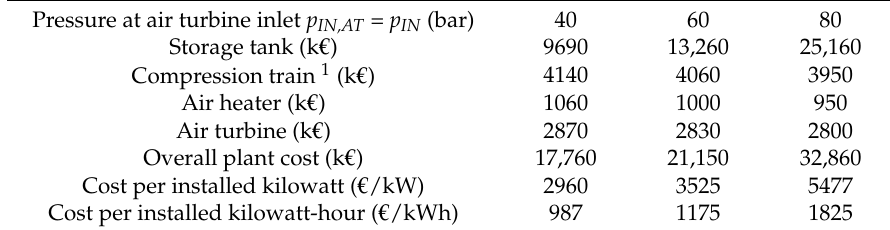
Table 4. CAES plant cost ( p ST = 100